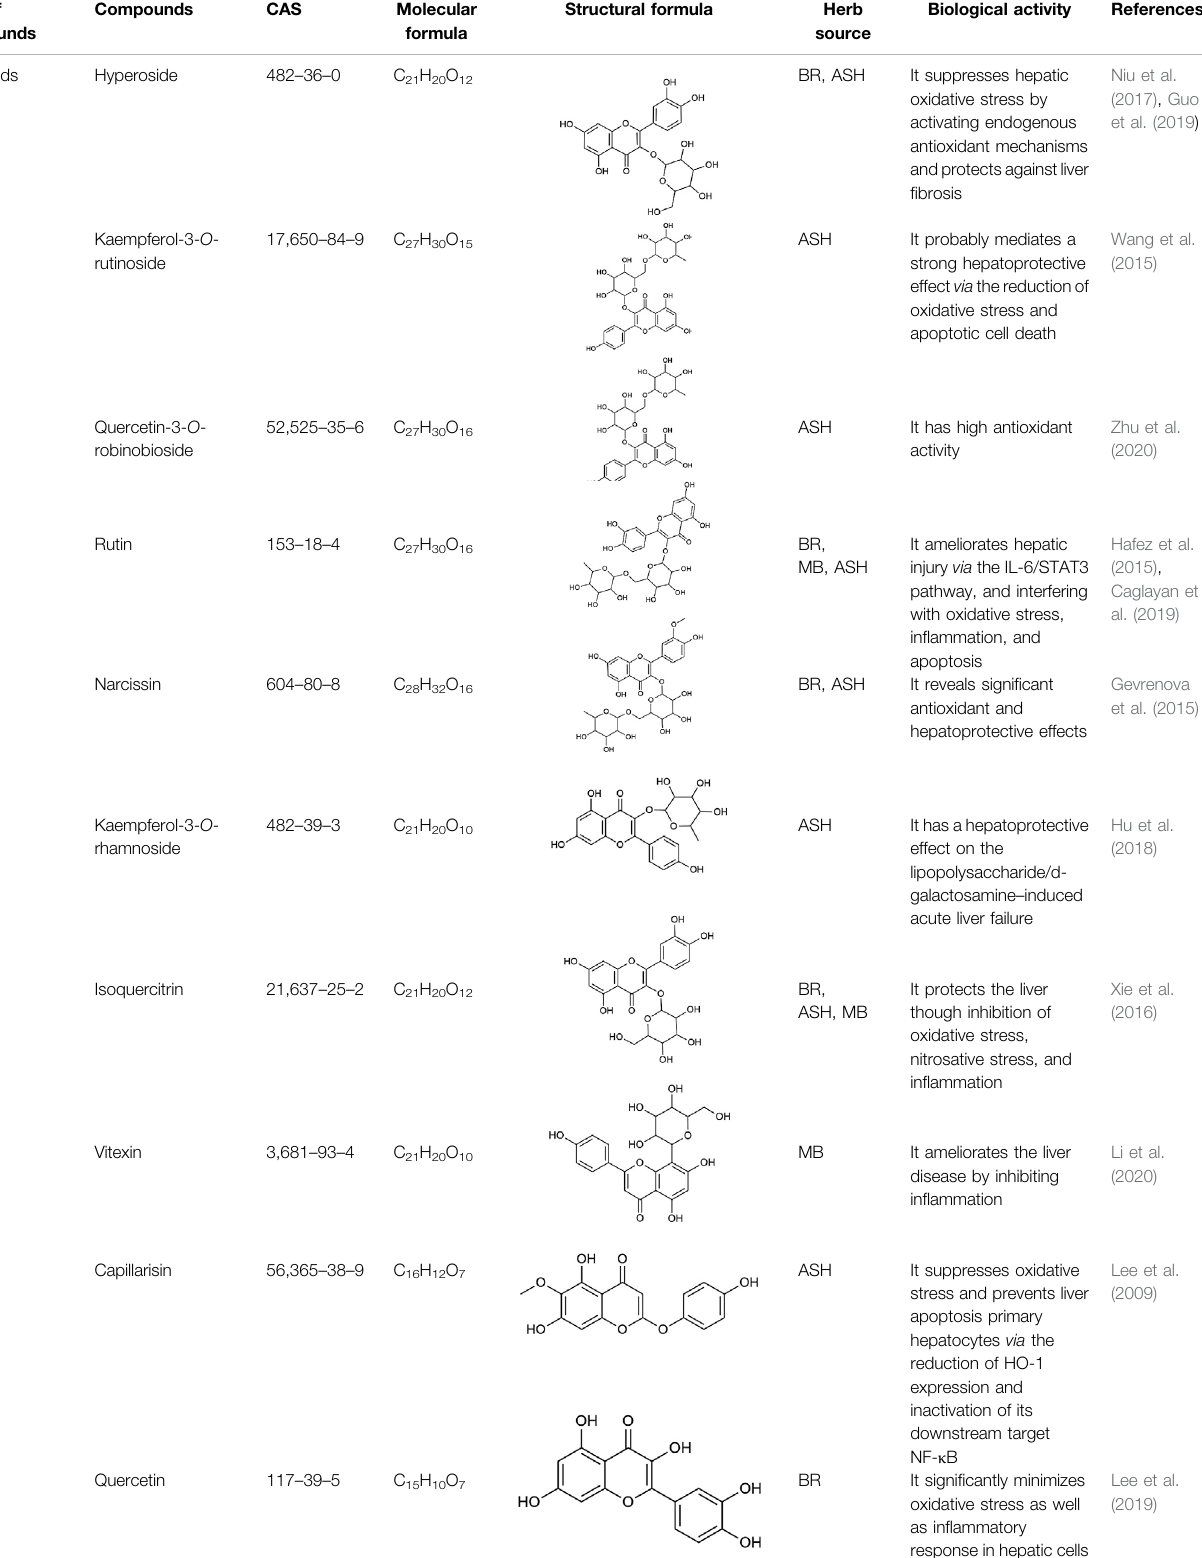
TABLE 2 | Screening results of active ingredients of Hugan